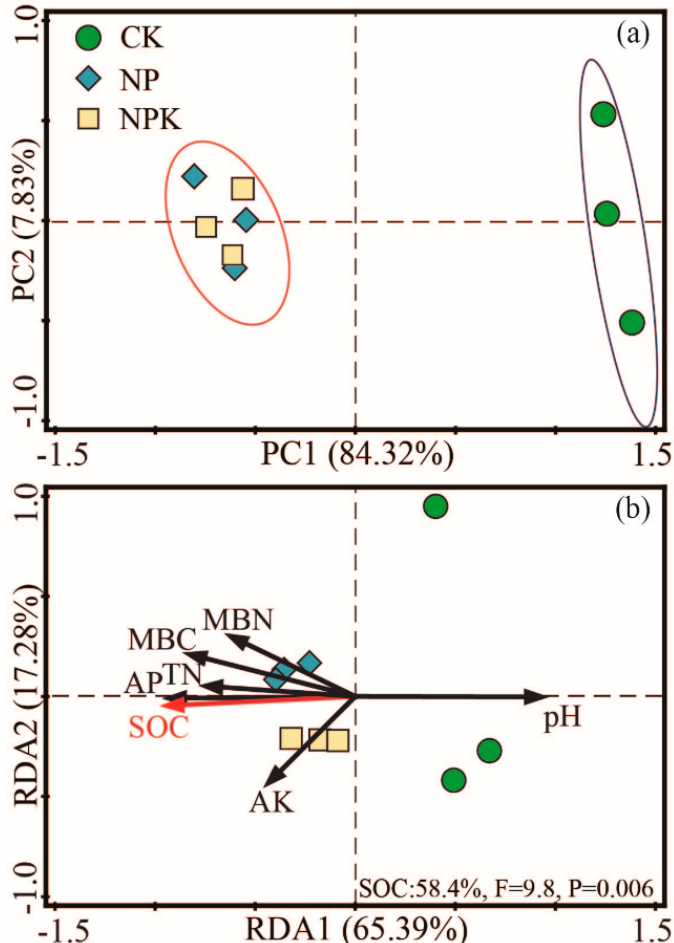
Figure 3. Principal components analysis (PCA) of enzymatic activities in soils from different long-term fertilizer treatments (CK, no fertilizer; NP, nitrogen and phosphorous fertilizer; NPK, nitrogen, phosphorus, and potassium fertilizer). The circled symbols indicate significant groupings. ( a ) Redundancy analysis (RDA) of the correlations between soil chemical parameters and soil enzyme profiles ( b ). The red arrow indicates that SOC had a strong and significant effect on enzymatic activities ( p < 0.05), explaining 58.4% of the variability. TN: total N; AP: available P; AK: available K; SOC: soil organic carbon; MBC: microbial biomass C; MBN: microbial biomass N.